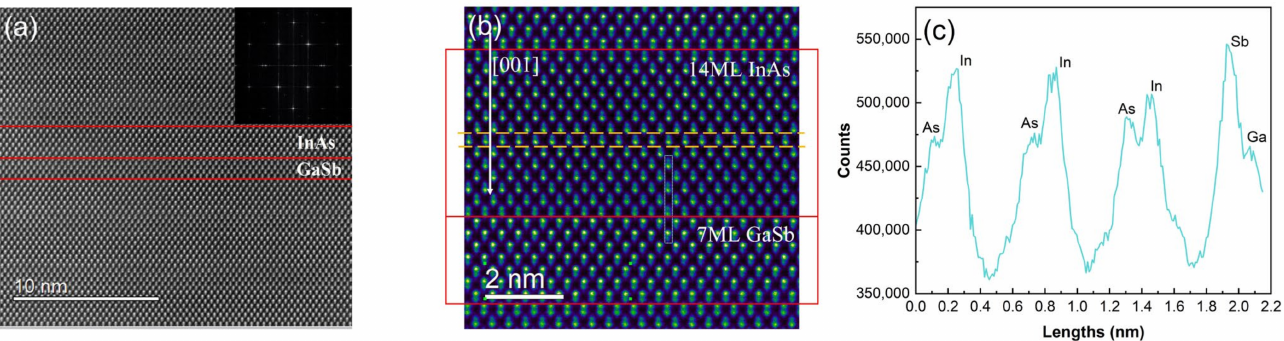
Figure 7. Superlattice STEM characterization images. ( a ) HAADF images of InAs/GaSb superlattice heterojunctions; ( b ) STEM diagram containing one period; ( c ) peak positions of In, As, Ga, Sb (according to the blue box in ( b